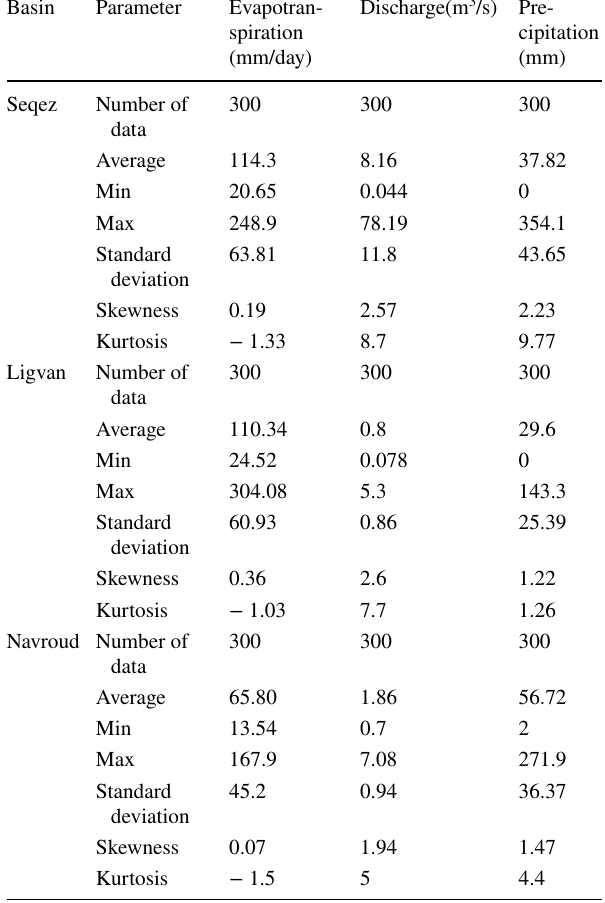
Table 2 Annual statistics for each